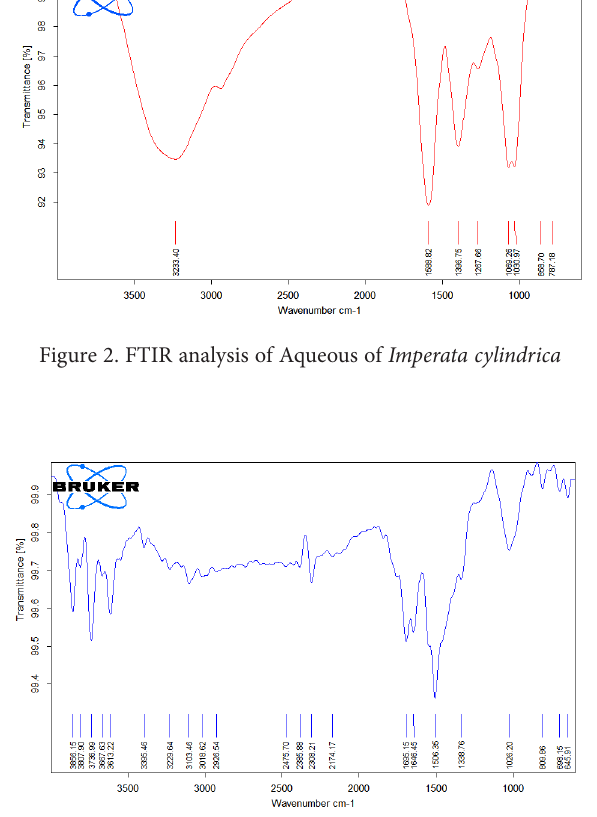
Figure 3. FTIR analysis of Silver Nano particle of Imperata cylindrica (1